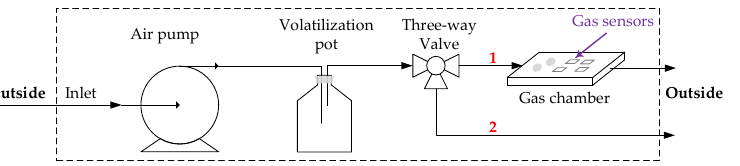
Figure 3. The gas route of SMUENOSEv2. Red bold numbers 1 and 2 indicate the two gas route branches in the downstream side of the three-way valve.